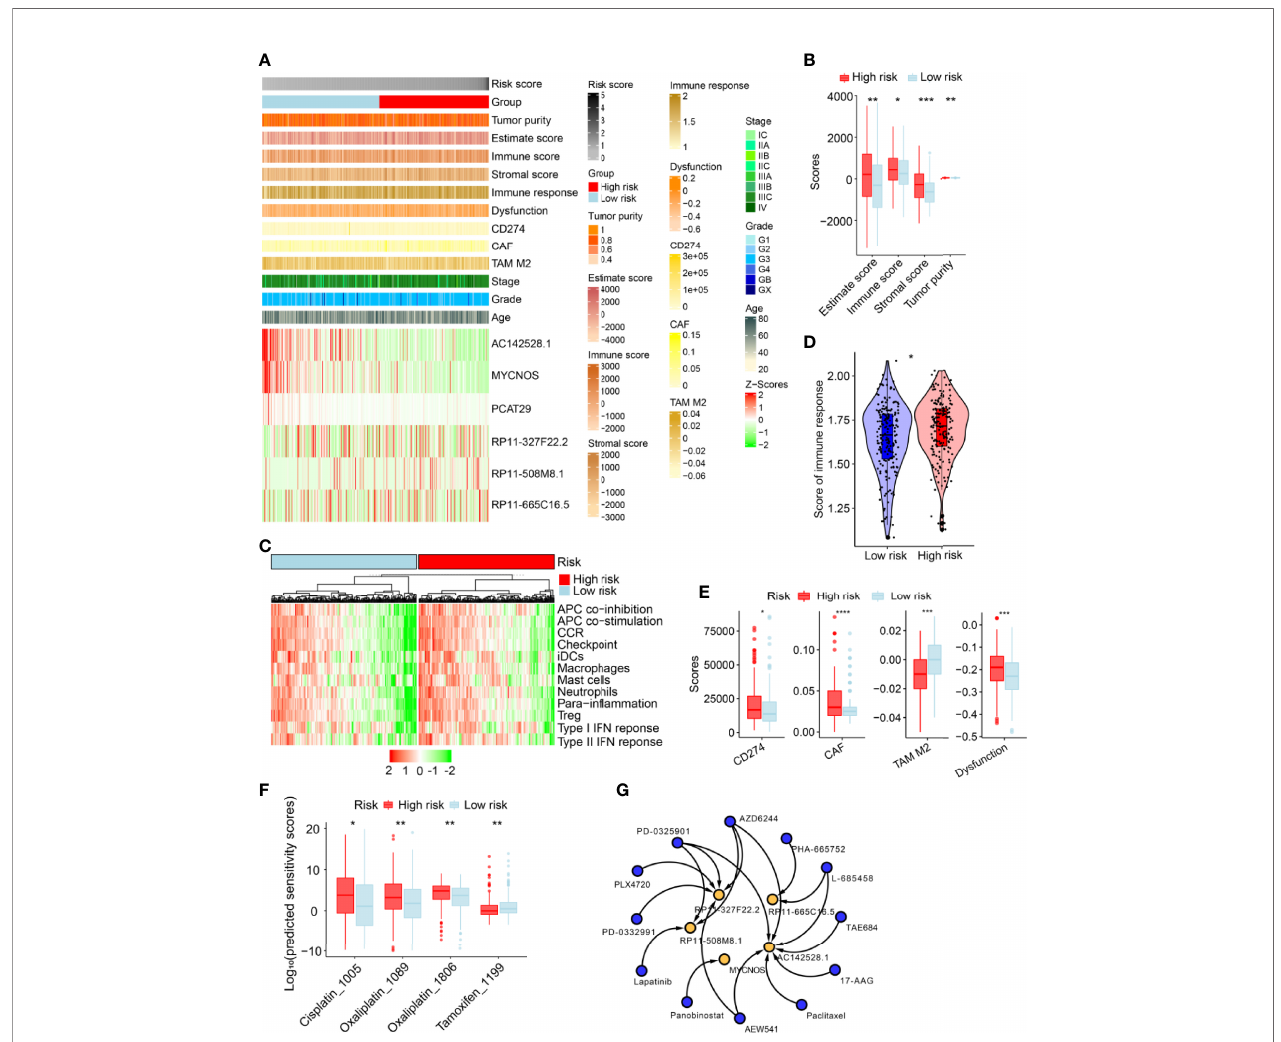
FIGURE 6 | Estimation of immune-related factors using the risk model in the entire set. (A) Heatmap of associations between the expression levels of the six m 6 A/ m 1 A/A-I/APA-related lncRNAs and clinicopathological features. (B) The differences in stromal and immune cell scores between low- and high-risk patients were analyzed. (C) The indicated standards of the immunity index for each patient were visualized via heatmaps, with red representing high expression, and green representing relatively low expression. (D) The differences in immune response between low- and high-risk SOC patients. (E) Estimation of cancer immunotherapy response. (F) Differences in sensitivity against clinical applied drugs. (G) Twelve potential drugs (blue) were screened based on interactions of the RNA adenosine modi fi cation writer-related lncRNAs (yellow) in the drug – lncRNA module of LncMAP database. Only statistically signi fi cant results are shown ( P < 0.05). *P <0.01, **P <0.05, ***P <0.001, ****P